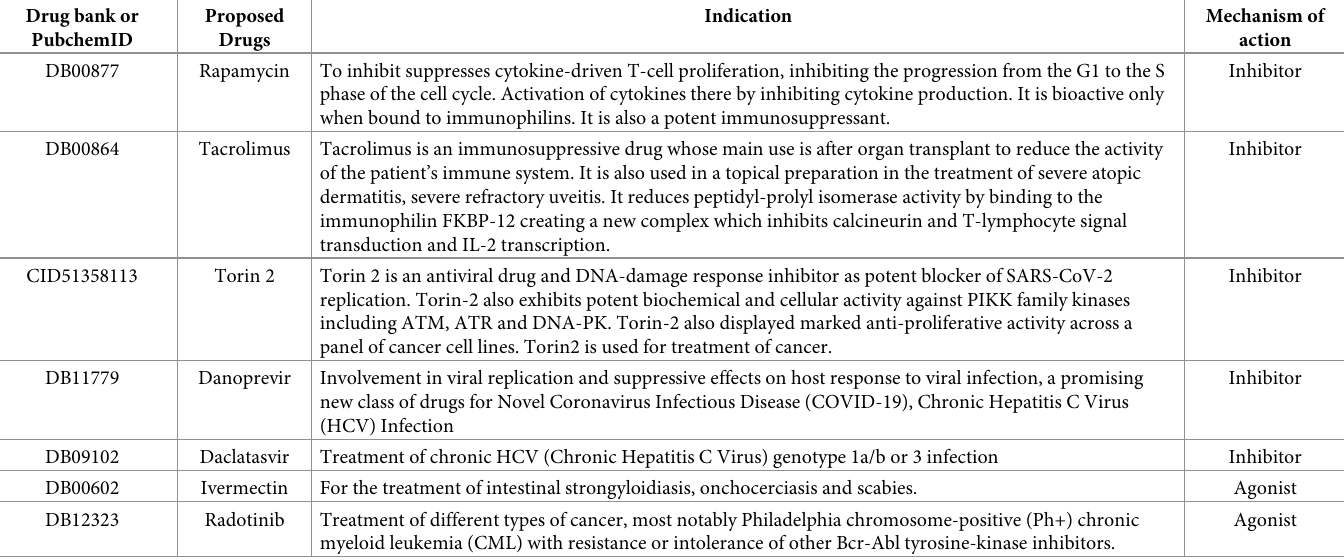
Table 4. Indications and mechanism of actions for the proposed repurposable drugs.